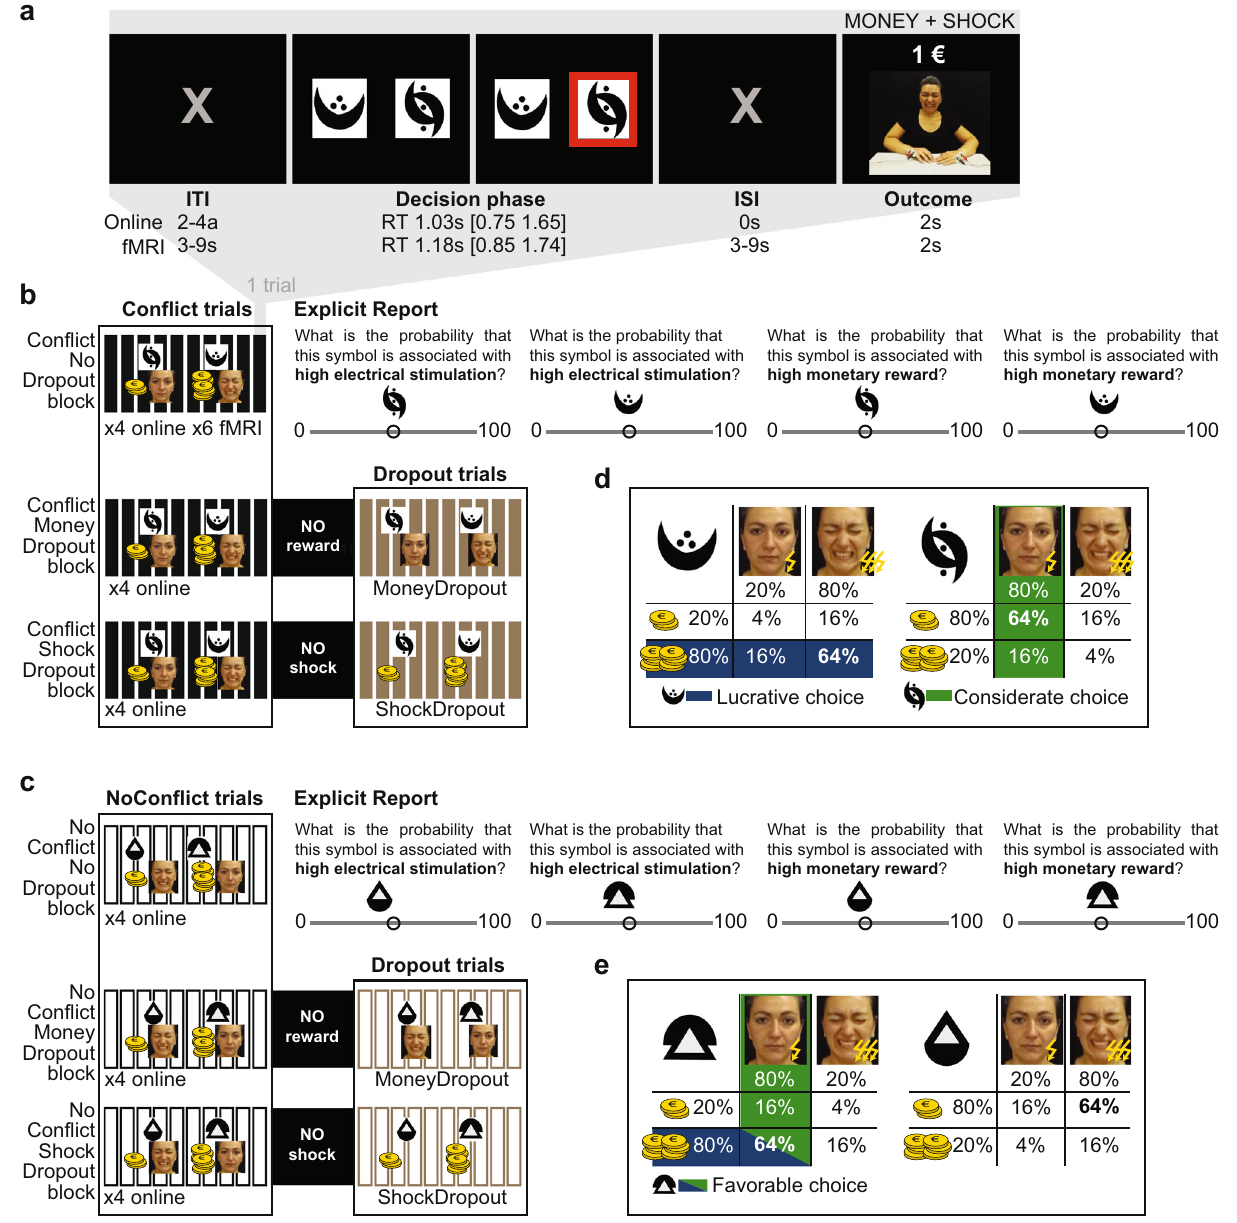
Fig. 1 | Learning task. a Trial structure. Red outline indicates an exemplary choice for a particular trial. Pictures showing the confederate ’ s response are still frames captured from one of the videos used in the Online experiment in which the con- federate received a painful shock (Supplementary Note §1). Inter-trial (ITI) and inter-stimulus(ISI)intervalswereadaptedtothefMRIandOnlinesituation,andare indicated separately below each relevant instance of the trial. For illustrative pur- poses, median reaction times (RT), and 25% and 75% quartiles, are estimated from the fMRI and Online Con fl ictNoDropout blocks, and the fi rst 10T of the Online Con fl ictDropout blocks, as they have the same structure as Con fl ictNoDropout blocks. When considering all Online trials, the median is 0.91 [0.67 1.38]. b , c Different types of block used for the Con fl ict ( b ; fi lled in rectangles) and NoCon fl ict ( c ; empty rectangles) conditions (see also Table 1). Each rectangle represents a single trial within a block. The fMRI experiment only included the Con fl ictNoDropout blocks. The Online experiment included six different types of